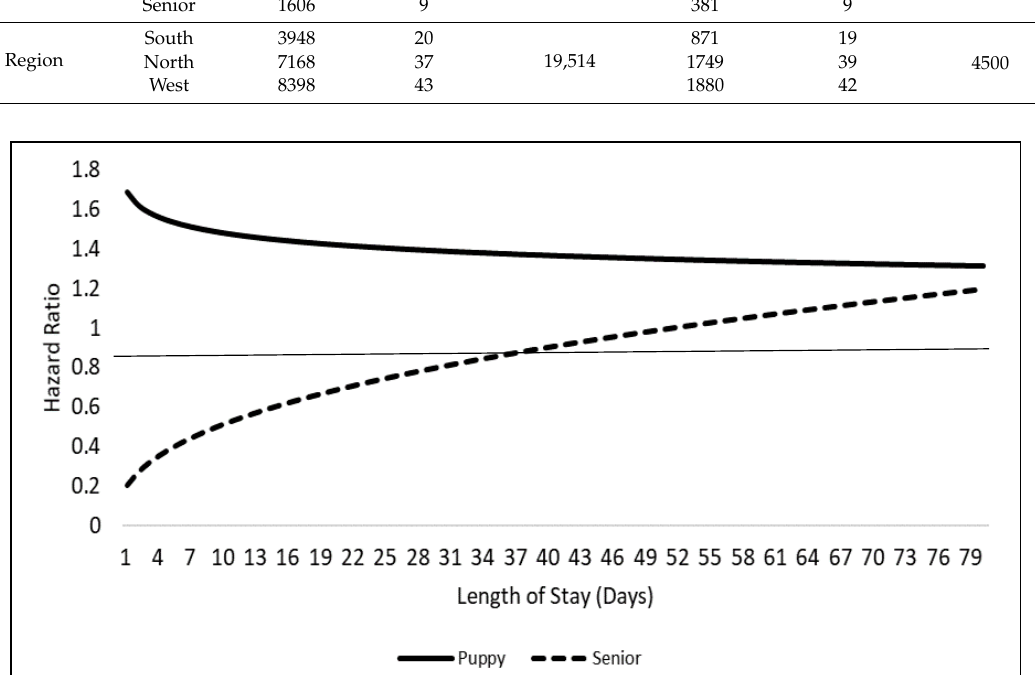
Figure 1. Model adjusted age group by length of stay interaction displayed as hazard ratios, estimated from the simple random sample of 4500 dogs, compared to the referent adult group.